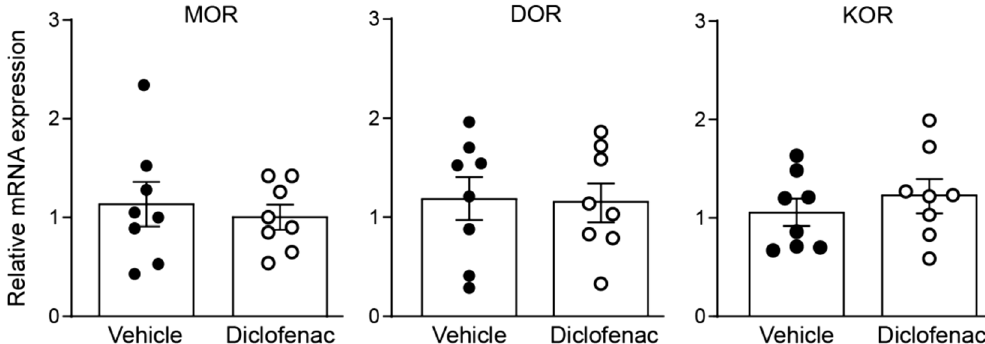
Figure 6. Expression of opioid receptor mRNAs in DRG. mRNA levels of MOR, DOR and KOR after daily subcutaneous treatment with vehicle or diclofenac (DCF; 20 mg/kg) at 4 days after intraplantar complete Freund’s adjuvant inoculation. P > 0.05 versus vehicle, two-tailed unpaired t-test. Data represent relative mRNA expression levels normalized to GAPDH, are expressed as fold change versus vehicle, and are shown as means ± SEM and individual data points (n = 8 samples per